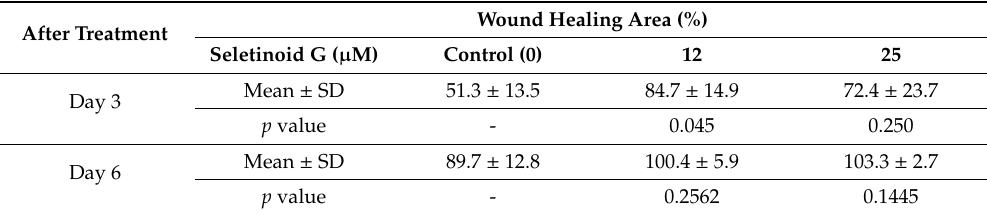
Figure 3. In vitro wound-healing effect of seletinoid G on a human skin equivalent wound model (MatTek, EFT-400-WH). Seletinoid G (12 or 25 µ M) was applied every other day; on days 3 and 6, the skin equivalents were fixed with 4% formaldehyde ( n = 3 per group). Three-dimensional imaging was performed using optical coherence tomography (OCT) microscopy. Blue color indicates the regenerated epidermal area. Scale bars indicate 1 mm. Table 1. The quantification of wound-healing area, as shown in Figure 3. In a human skin equivalent wound model, we quantify wound-healing area (% of initial wound area at day 0, n = 3 per group) by measuring the regenerated lengths in epidermis via an Image J software from individual OCT XZ-axis images. (“ p value” vs. control group).